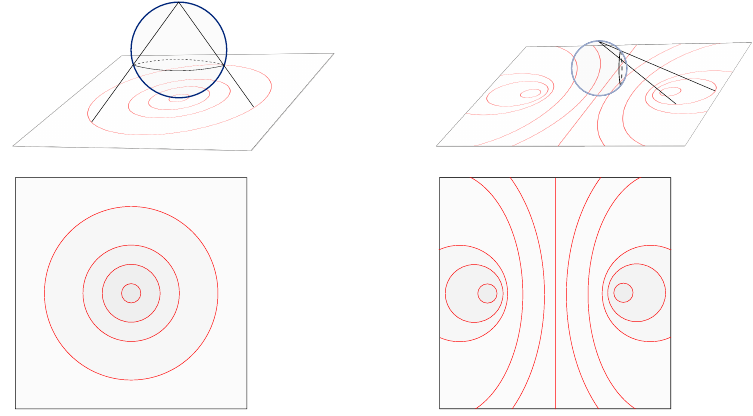
Figure 1 . Two different stereographic projections. The one on the left foliates the sphere by lower-dimensional spheres from north to south, which get projected onto the plane as spheres of increasing radius. The one on the right foliates the sphere by lower-dimensional spheres from west to east, which get projected onto the plane as two sets of spheres surrounding two points. The sphere passing through the north and south poles gets mapped to a lower-dimensional plane. The bottom line shows a direct view of the parameterization of the plane, radial coordinates on the left and owl coordinates on the